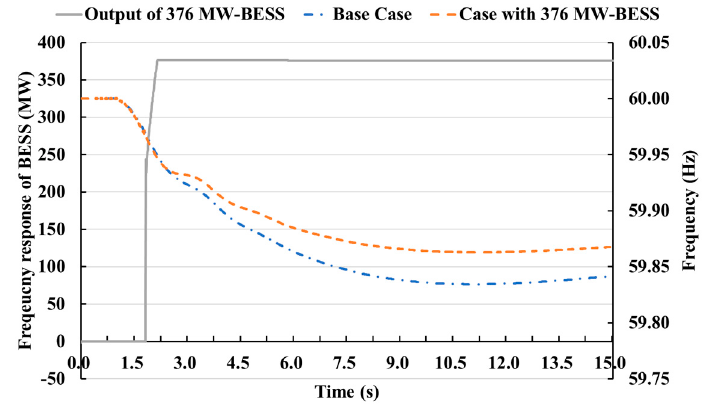
Figure 10. Comparison of result without and with BESS. Table 7. Evaluation result from Figure 10.